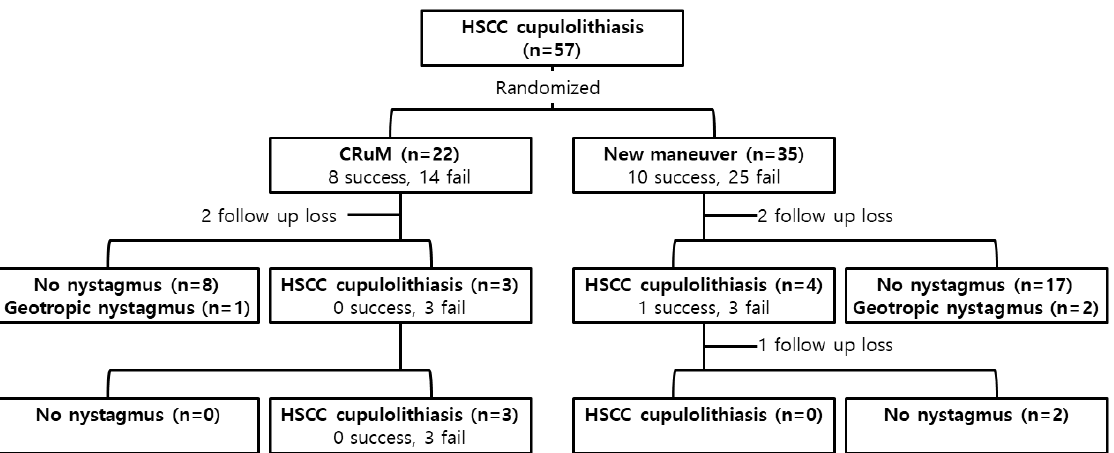
Figure 2. A summary of the treatment results through the follow-up. HSCC: horizontal semicircular canal, CuRM: cupulolith repositioning maneuver by mastoid oscillation.